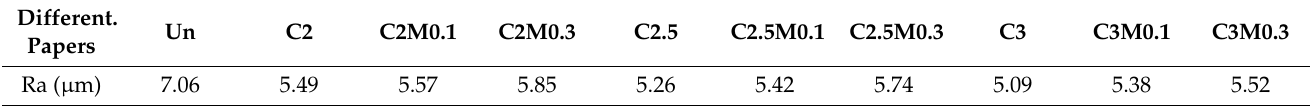
Table 4. The roughness average (Ra) of